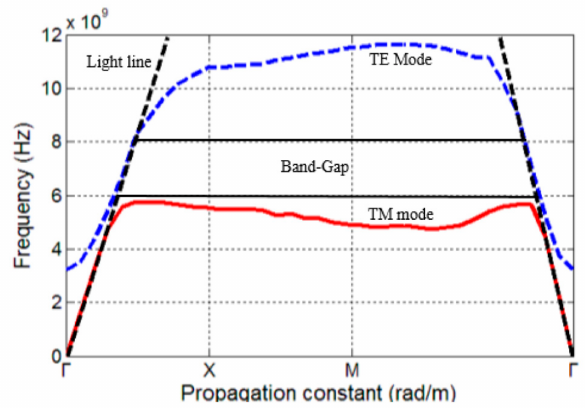
Figure 7. Dispersion diagram, adapted from